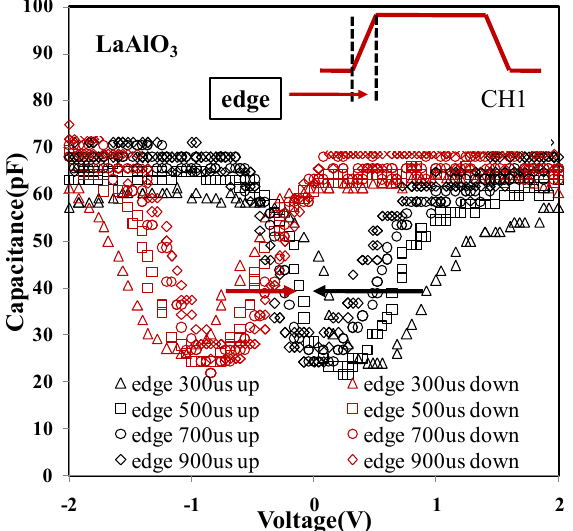
Figure 6. Capacitance (pF) versus voltage (V) of a LaAlO 3 sample. The variation of flat-band voltage was decreased with increasing pulse edge